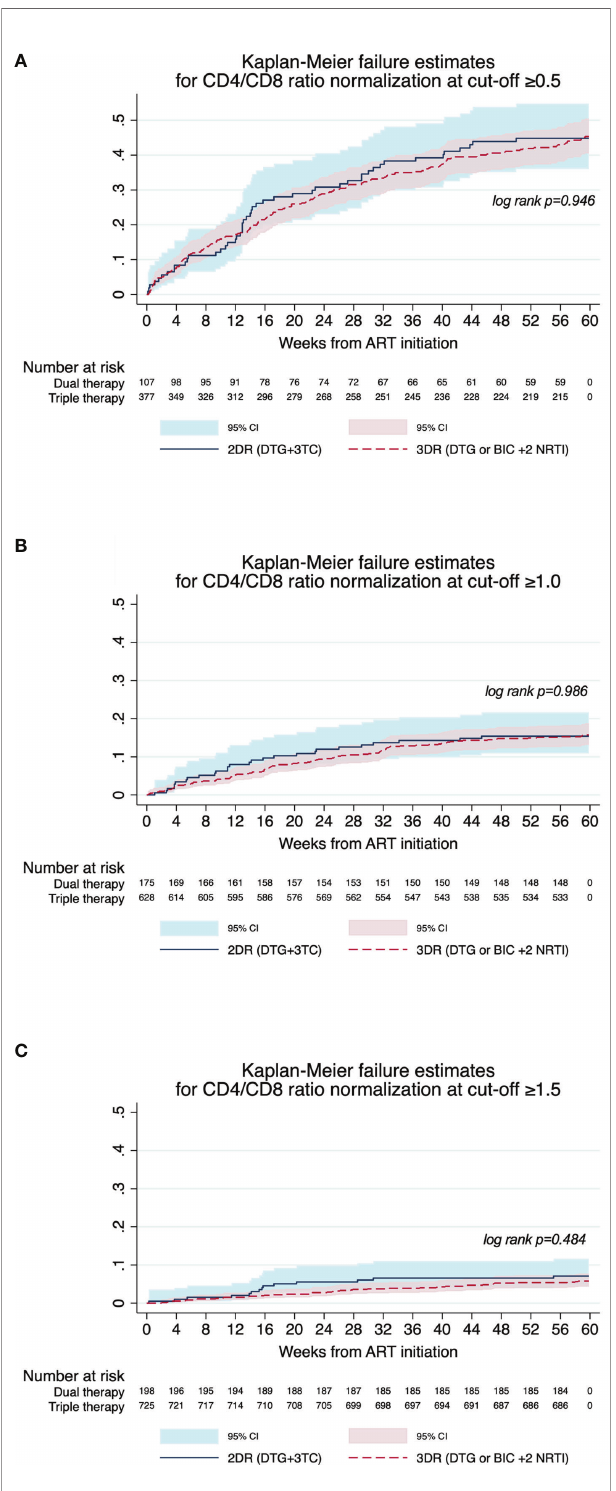
FIGURE 1 | Kaplan-Meier survival estimates for CD4/CD8 ratio normalization at 0.5, 1, and 1.5 cutoffs in participants with dual and triple ART. The graph shows survival estimates for CD4/CD8 normalization for the 0.5 (A) , 1.0 (B) and 1.5 (C) cutoff points, during the 48 + 12 weeks of follow-up. The p-values were obtained using the log-rank